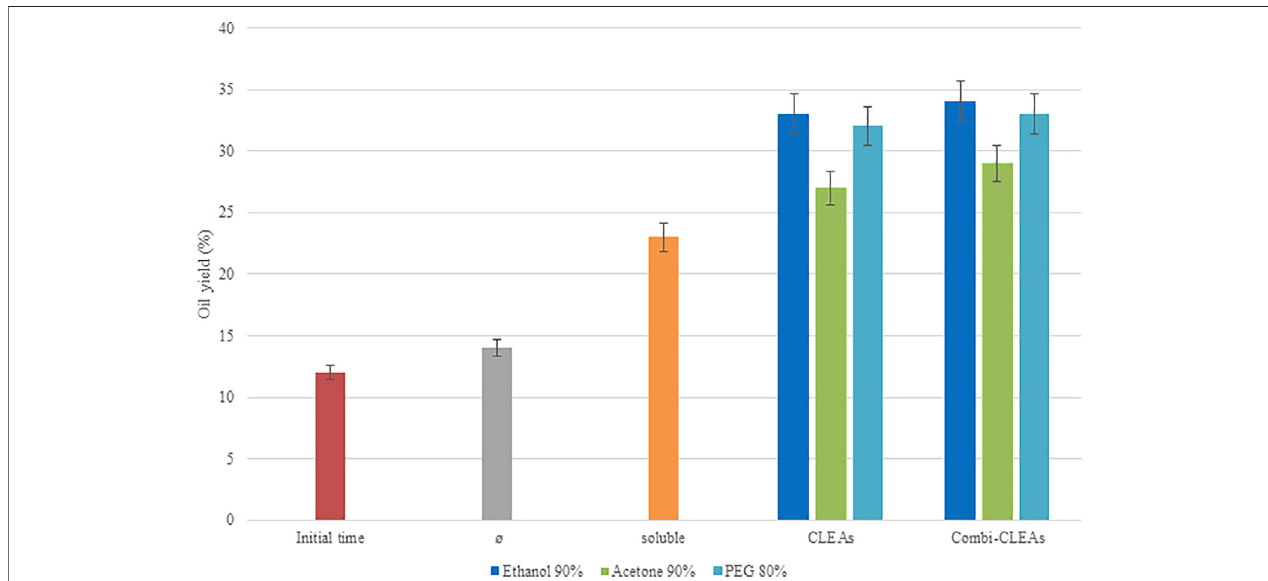
FIGURE6| Oilyields(%)obtainedafterenzymaticpretreatmentof N.gaditana biomassat55 ° CandpH5.0during6 hinanUSbathusingsolubleenzymes,optimal CLEAs, or optimal combi-CLEAs. Results were compared to initial time (unpretreated biomass) and microalgae biomass incubated in the US bath without enzymes (Ø).